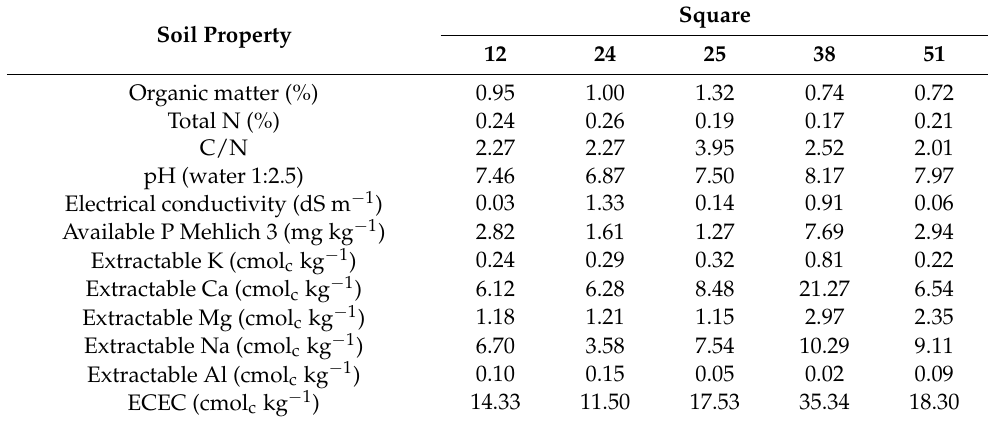
Table 1. General soil properties for the composite